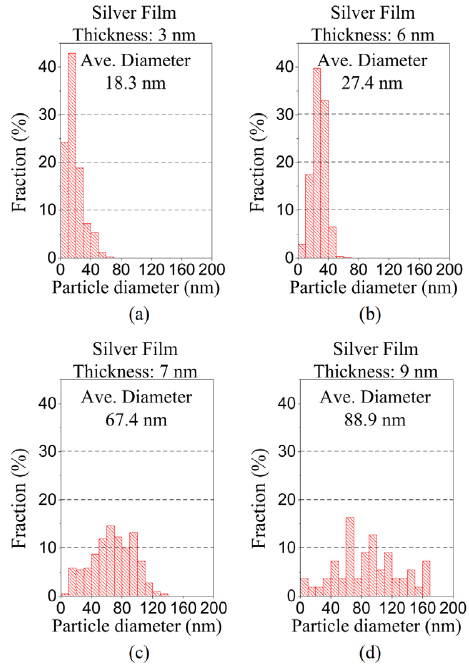
Figure 5. Particle distribution of the dewetted NPAs for the silver films with an original thickness of ( a ) 3 nm, ( b ) 6 nm, ( c ) 7 nm, and ( d ) 9 nm.